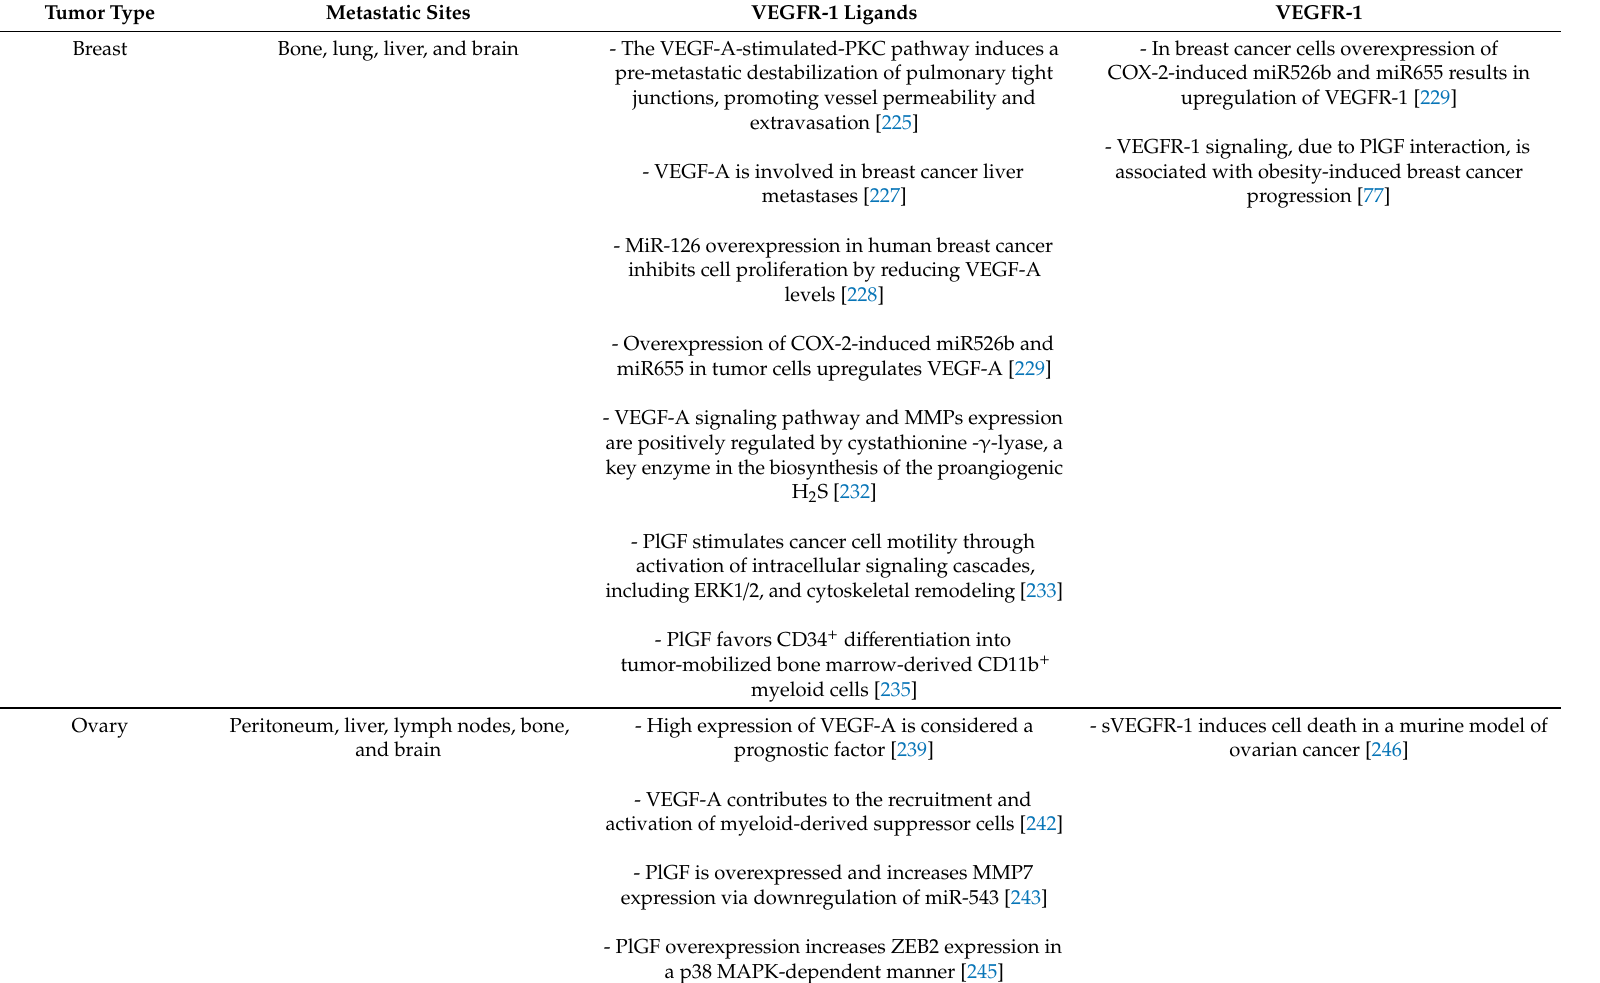
Table 3. Experimental evidence of VEGFR-1 and its ligands in the metastatic evolution of sex-specific